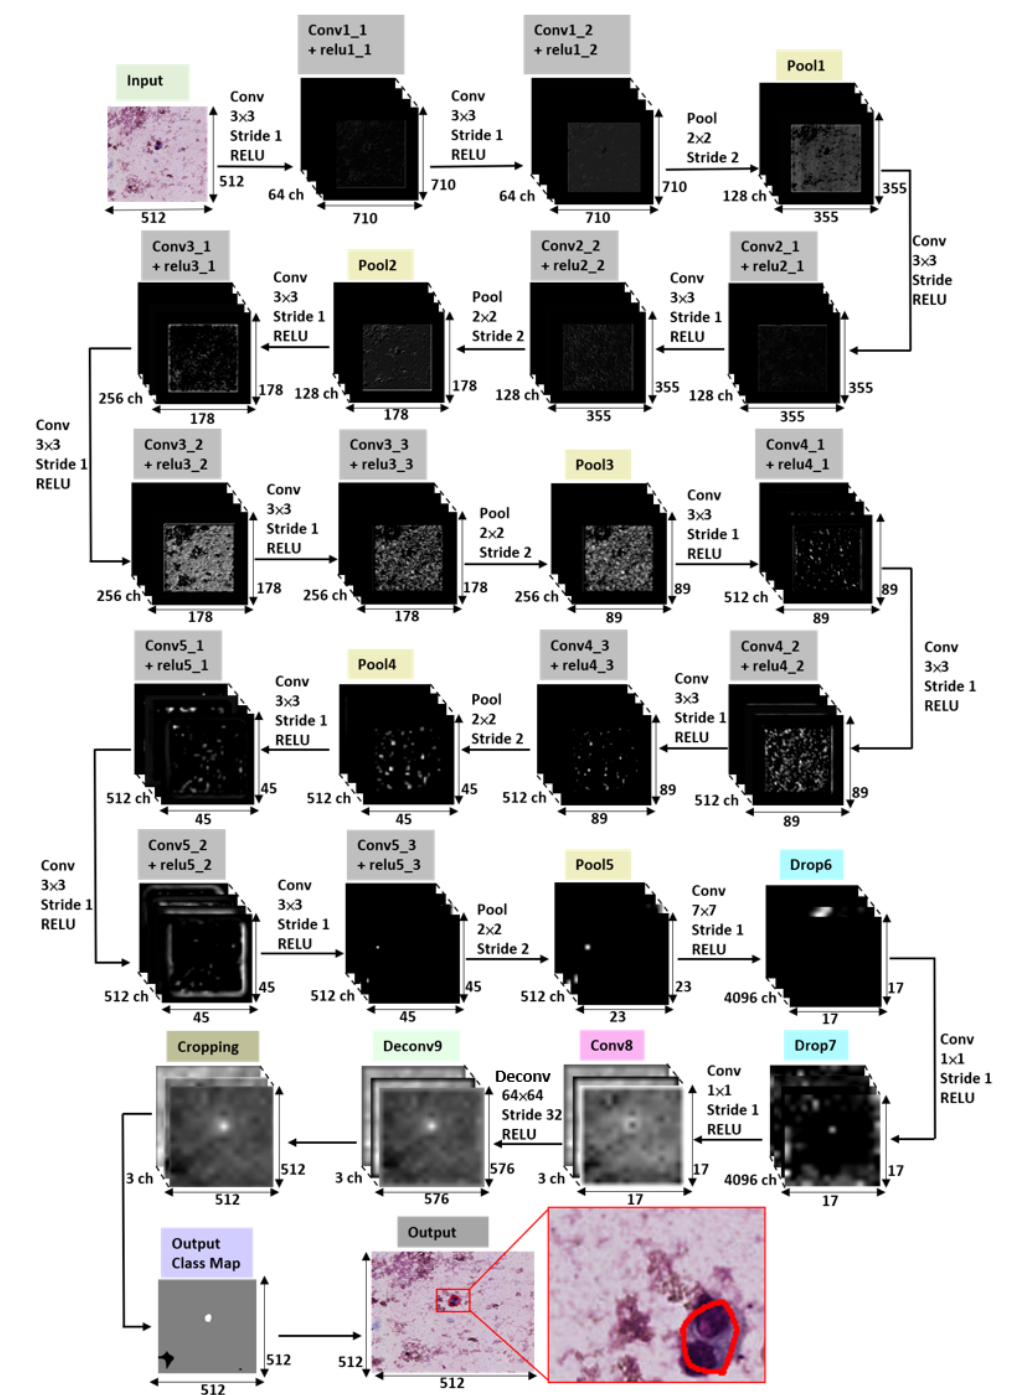
Figure 4. The detailed architecture of the proposed deep learning